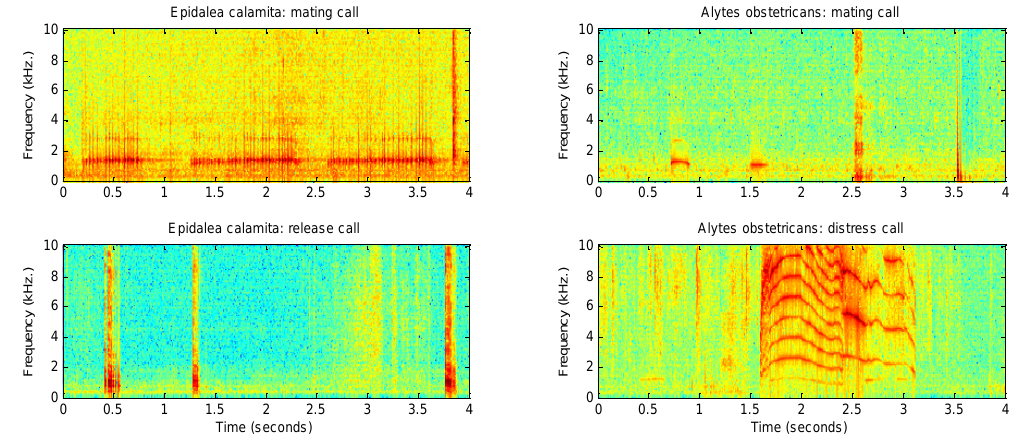
Figure 3. Spectrograms of sample calls for each sound class.